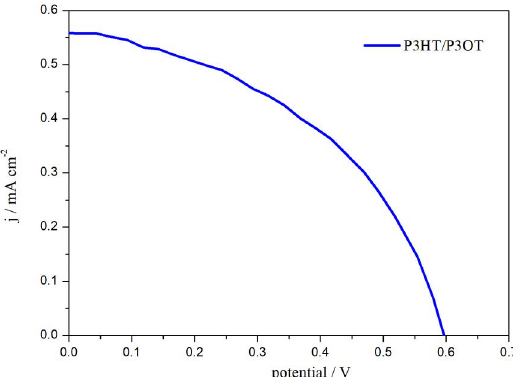
Figura 6. Typical j-V curve obtained from the cell analyzed under 100 mW cm -2 of simulated solar irradiation. Using the results shown in Figure 6, it was possible to determine the photovoltaic parameters of the device listed in Table 1 and calculate the energy conversion efficiency (ɳ) using Equation 1, being that, V = open-circuit potential, oc J = short-circuit current, FF = fill factor and P = solar sc in irradiation, of 100 mWcm -218 .